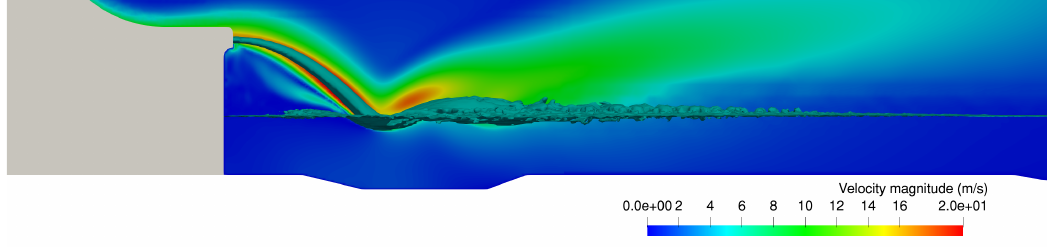
Figure 9. Local structure and contour maps of water flow speed in the impinging region of the jet at discharge flow rate of 300 m 3 /s.